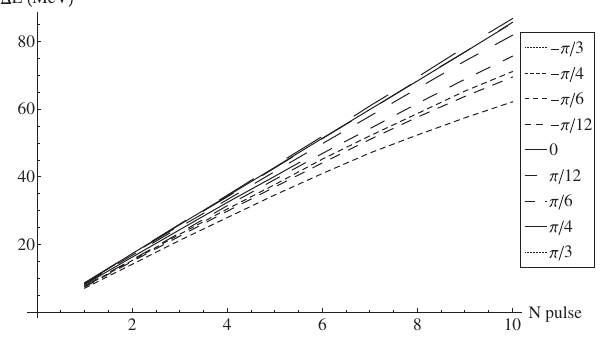
FIG. 5. Energy gain Δ E (in MeV) after crossing N laser pulses for 100 MeV electrons injected along x at different positions in the z